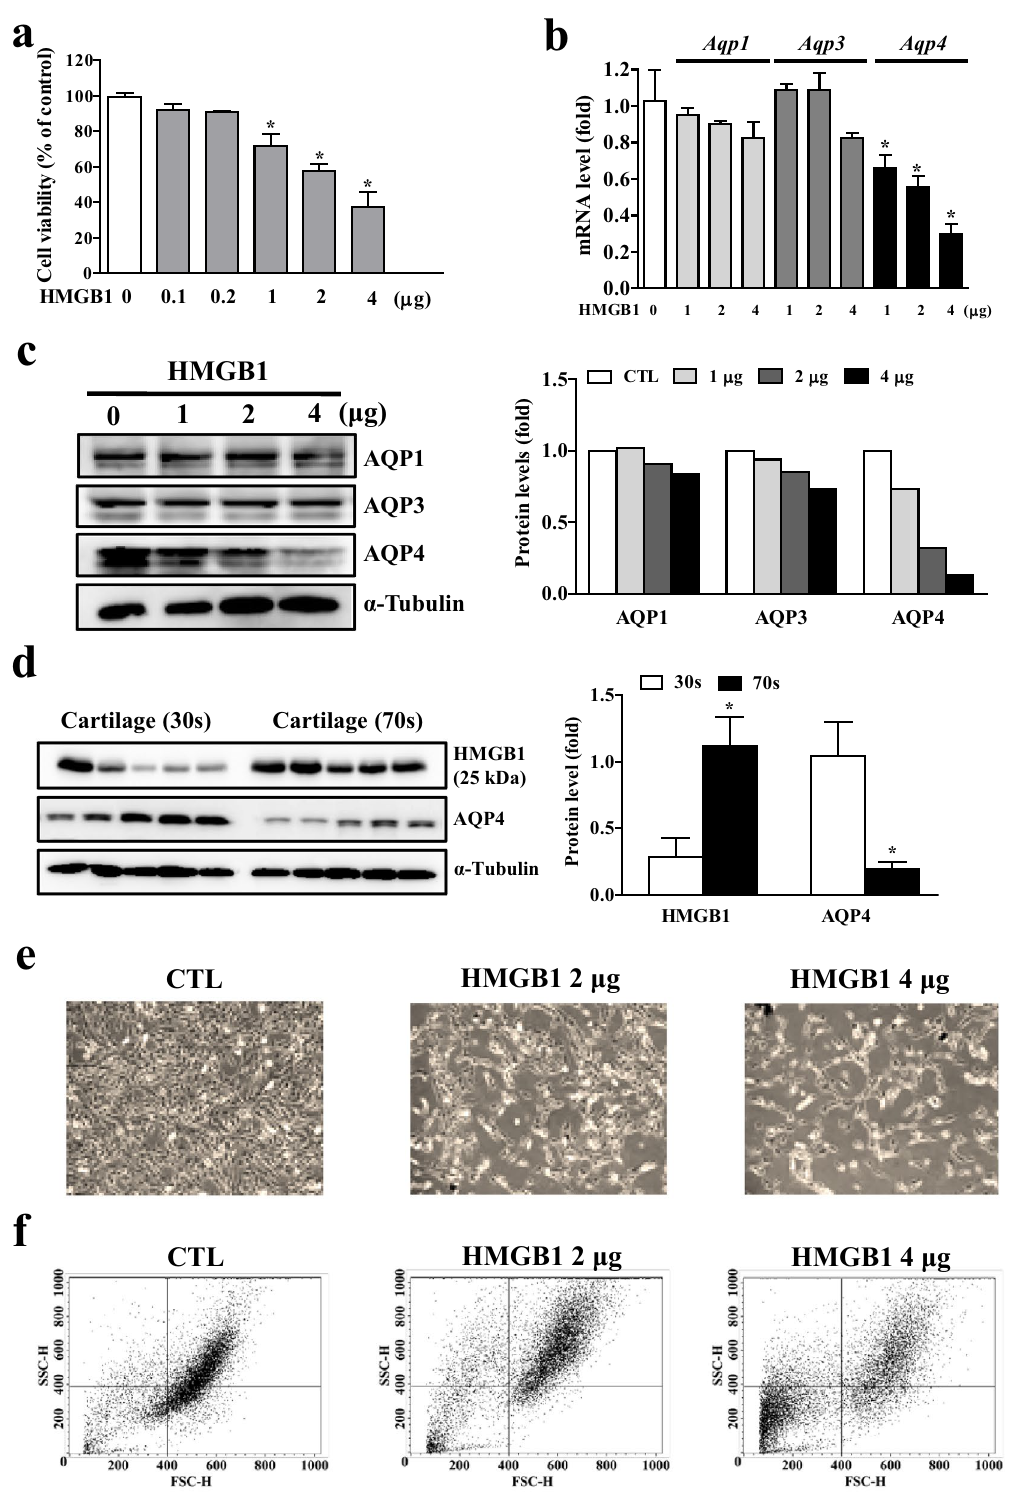
Figure 5. Reduction in aquaporin expression and cell damage by HMGB1. ( a ) Cell viability of chondrogenic C3H10T1/2 cells by HMGB1. ( b ) Expressions of AQP1, -3 and -4 mRNA by HMGB1. ( c ) Western blot analyses for AQP1, -3 and -4 protein expression by HMGB1. Densitometric analyses of the western blots are shown on the right. ( d ) HMGB1 and AQP4 protein expression in young and old aged cartilage tissues (n = 5 per group). Densitometric analyses of the western blots are shown on the right. ( e ) Morphology of chondrogenic C3H10T1/2 cells by HMGB1 administration. ( f ) Flow cytometry analysis in HMGB1-treated C3H10T1/2 cells. Forward scatter (FSC) represent the cell size, and side scatter (SSC) data represent the complexity or granularity of the